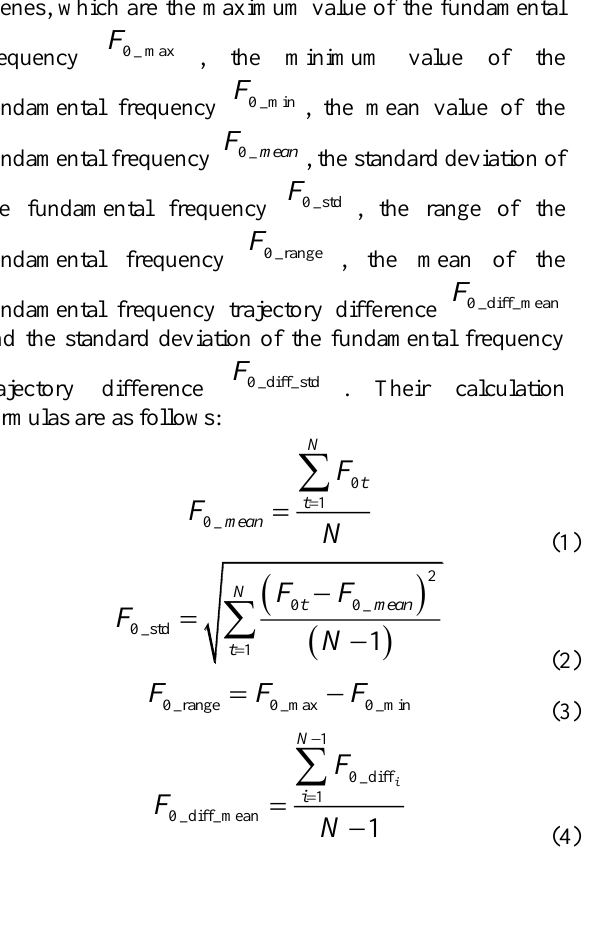
algorithm, independent component analysis algorithm,